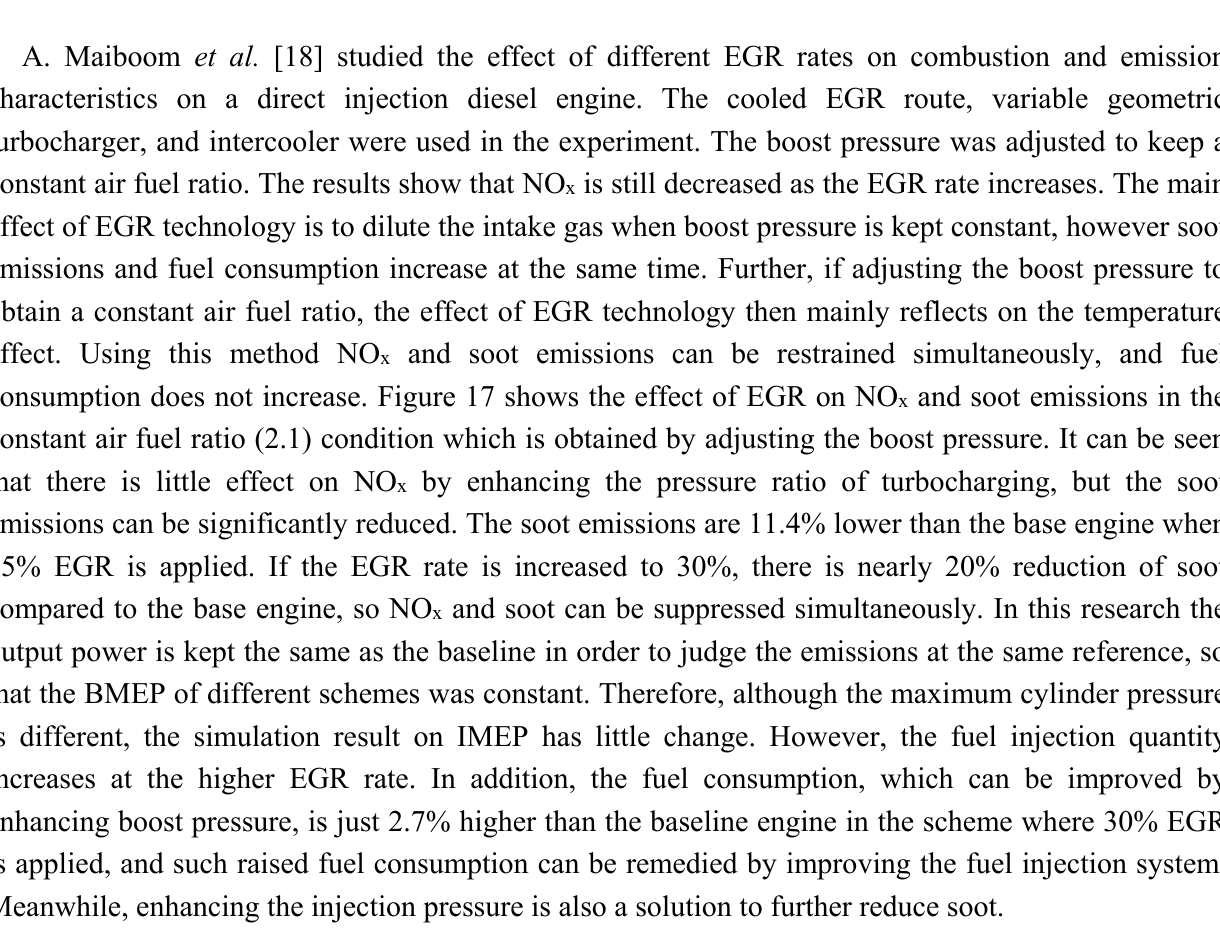
Figure 16. Influence of EGR on emissions at constant boost pressure.